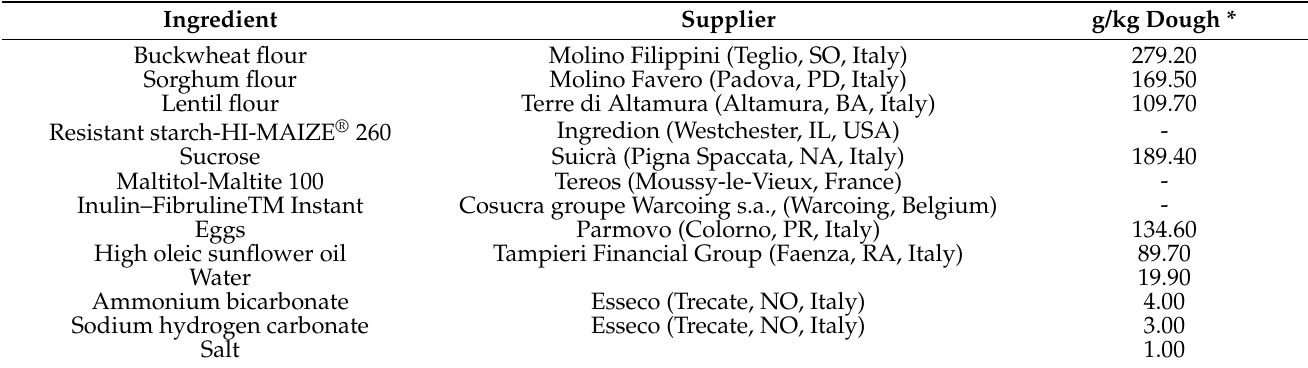
Table 1. Ingredients used for the production of gluten-free biscuits samples.